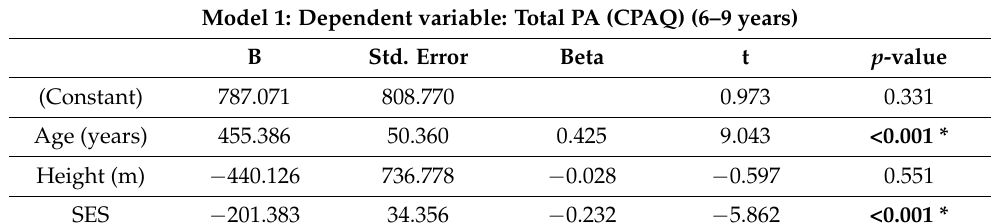
Table 5. Predictors of self-reported and objective PA among school children’s